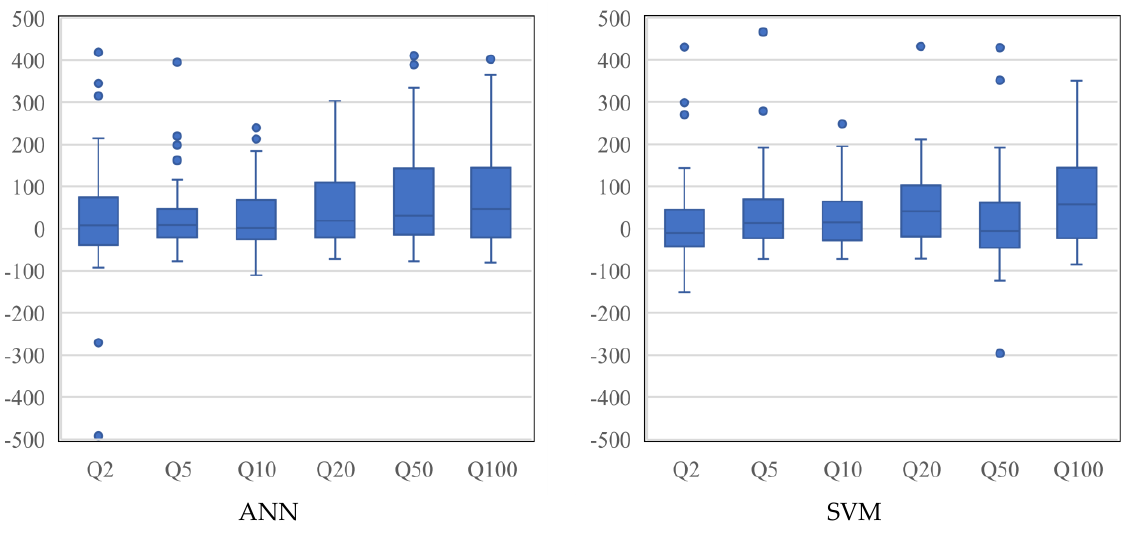
Figure 7. RE for the ANN and SVM methods (y-axis represents RE in %).